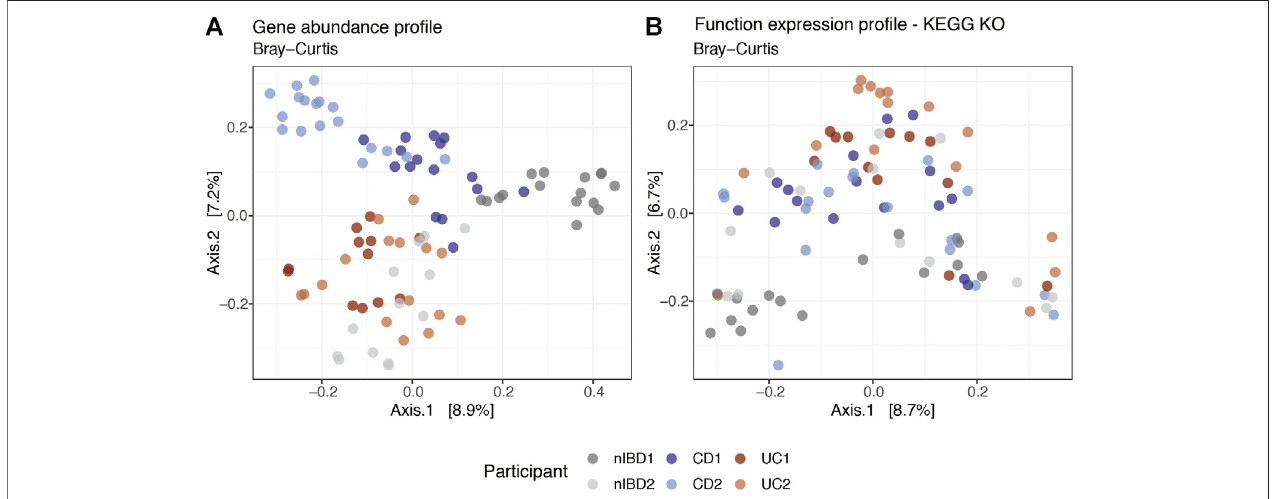
FIGURE4| Projectionofthe fi rsttwoprincipalcoordinatesbasedonexpressionpro fi lesBray – Curtisdissimilarityat (A) geneand (B) functionKEGGKOlevelsusing a subset of 91 samples from IBDMDB. Labels correspond to the sample alias and are colored by condition (patients